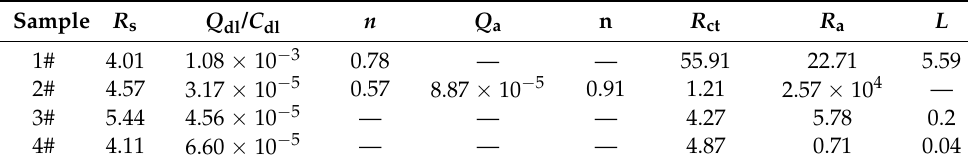
Table 4. Calculated values of EC components in Figure